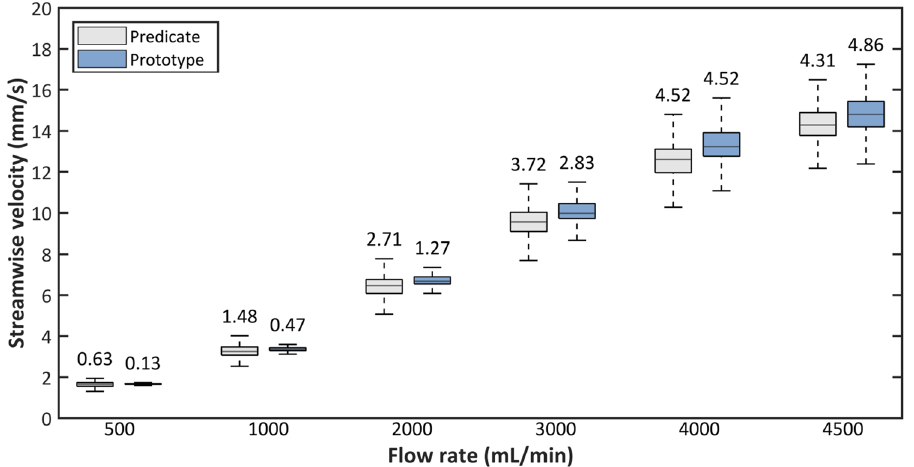
Figure 4. Box and whisker plots of streamwise flow velocities in the membrane modules of the predicate and prototype devices. Midlines show the median value, boxes cover the 25th to 75th percentile, and whiskers show minimum and maximum. The values above the plots of the predicate and final prototype indicate the velocity range between the top and bottom whisker.